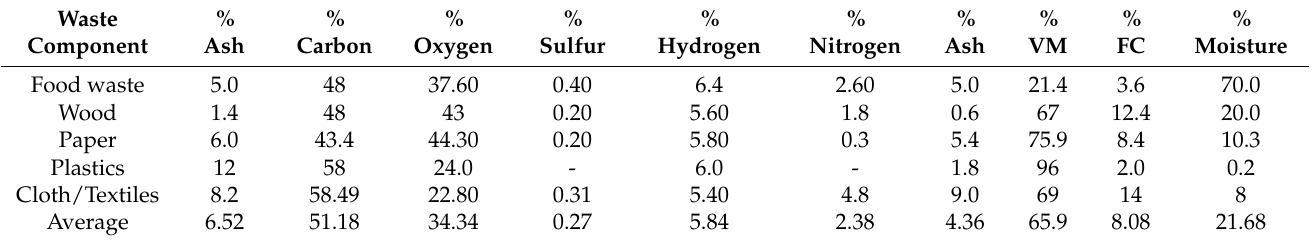
Table 2. Ultimate and proximate analysis of waste components in Nigeria.